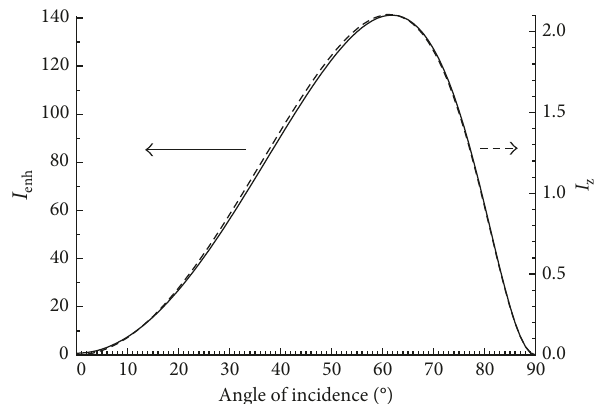
Figure 4: Angular dependencies of the intensity of the incident p -polarized light at the gold surface and the field enhanced by the touched sphere.